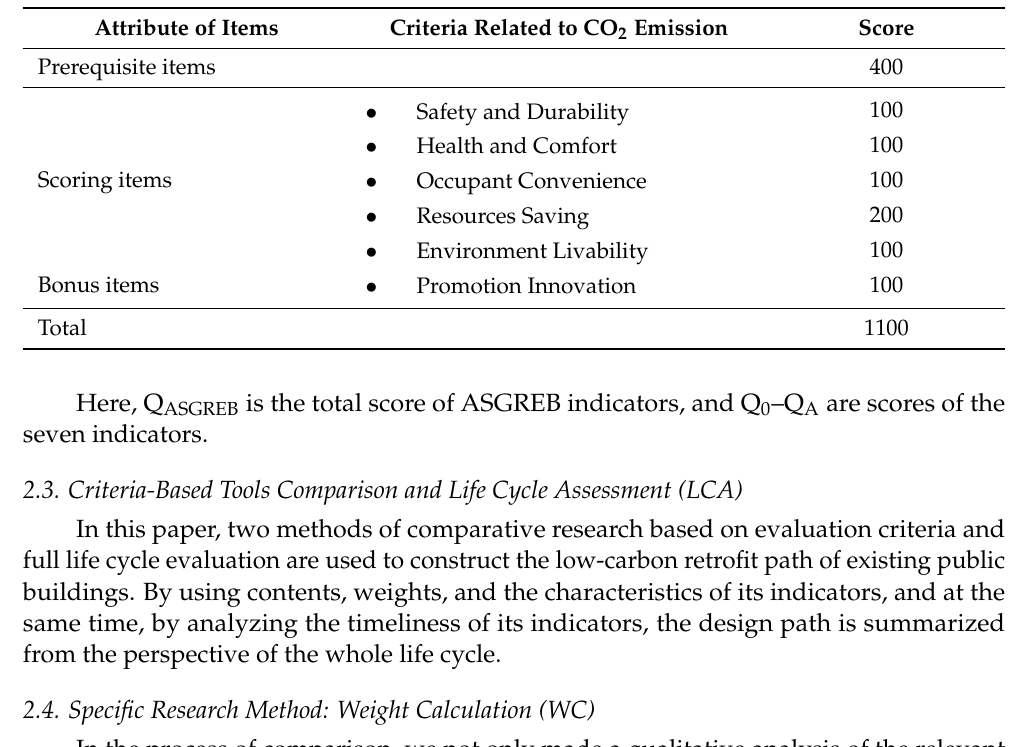
Table 5. Criteria of